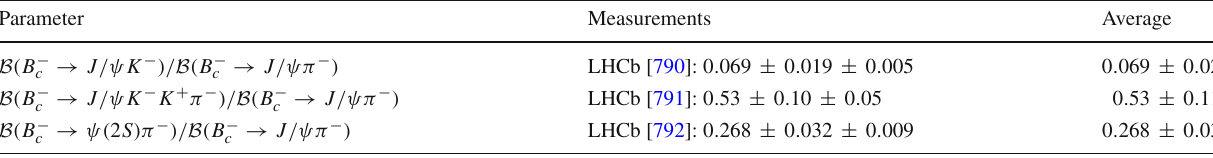
Table 203 Relative decay rates II